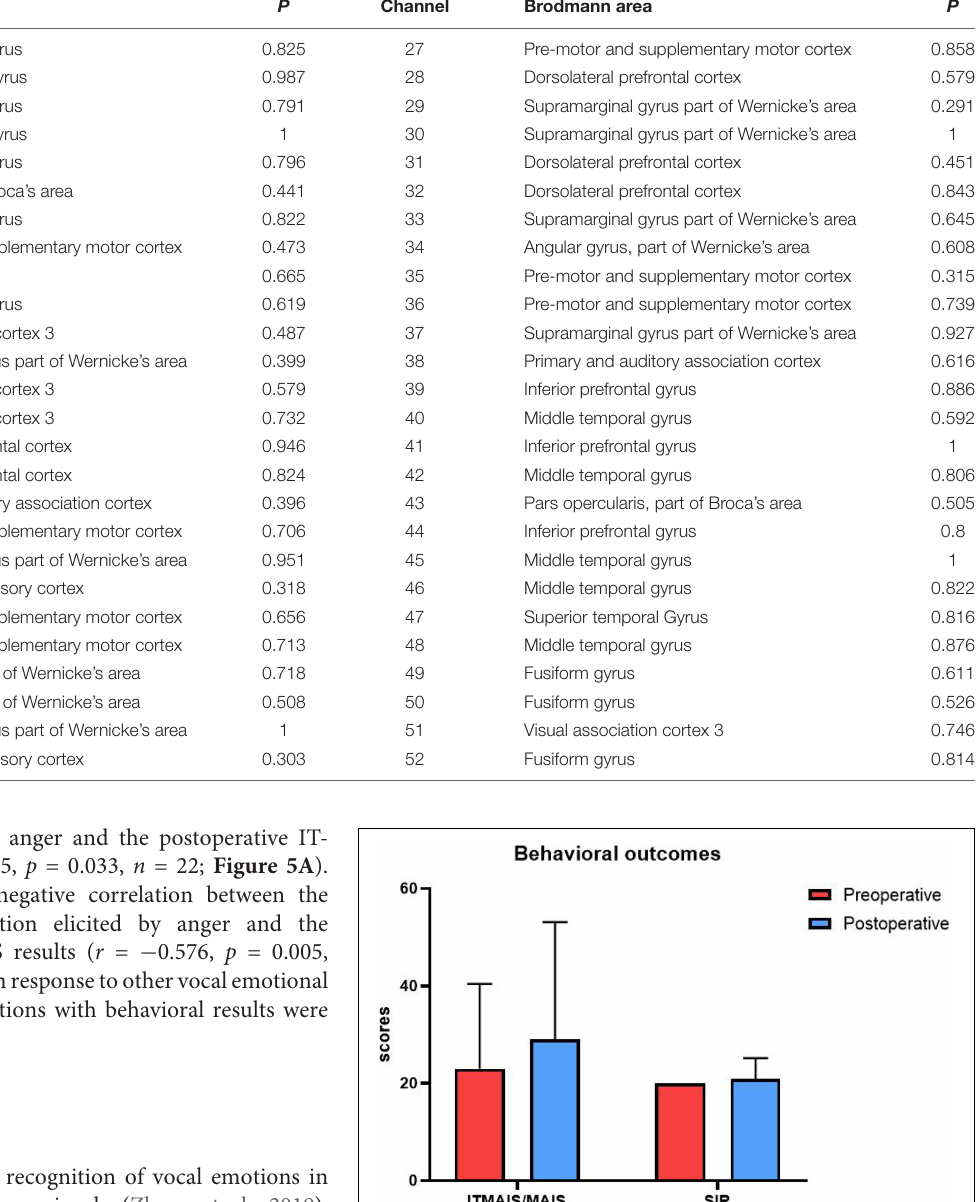
different for the left channels 21 and 22 [located in (pre-)SMA] and the right channels 40, 42, and 47 (located in STG and MTG) in the present study ( Figures 4A–E ). The neural response of the left (pre-)SMA to vocal emotional stimulation changed from preoperative activation to postoperative inhibition.